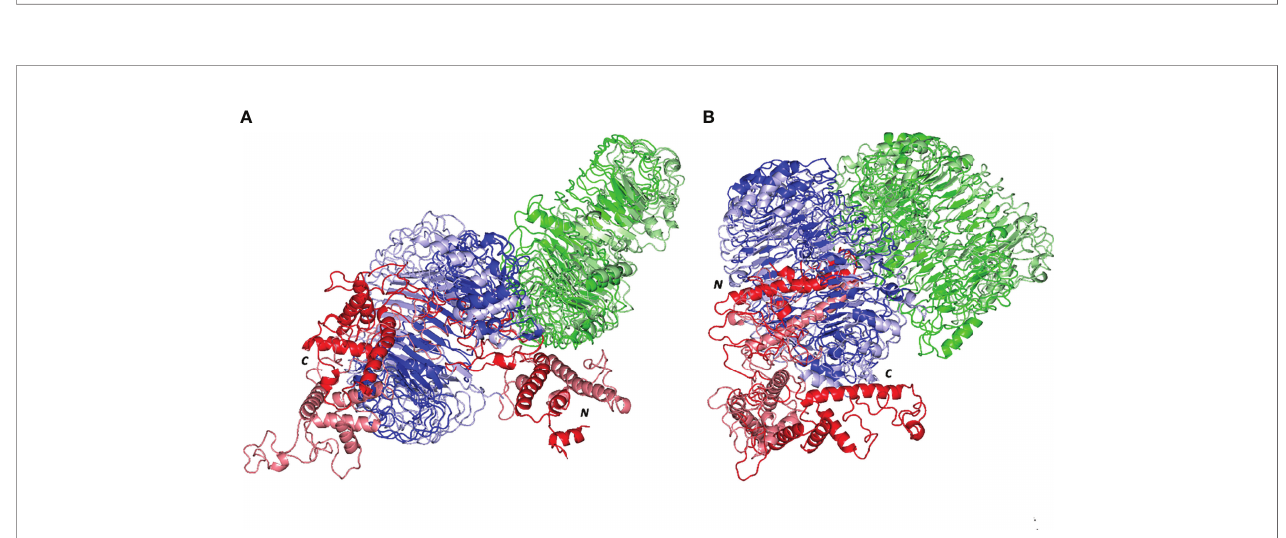
FIGURE 8 | Comparative dynamic conformation/orientation for the simulated multiepitope vaccine/TLR models. Aligned initial and fi nal simulated trajectories of each model; (A) multiepitope vaccine/TLR-4; (B) multiepitope vaccine/TLR-8. Proteins are represented as 3D cartoons and differently colored in green, blue, or red for respective TLR protomer-A, TLR protomer-B, or the epitope proteins, as well as, in dark or light colors in regard to their respective extracted 0 ns or 100 ns trajectories. The carboxy and amine terminals of the simulated multiepitope vaccines are assigned with C and N -letters, respectively.